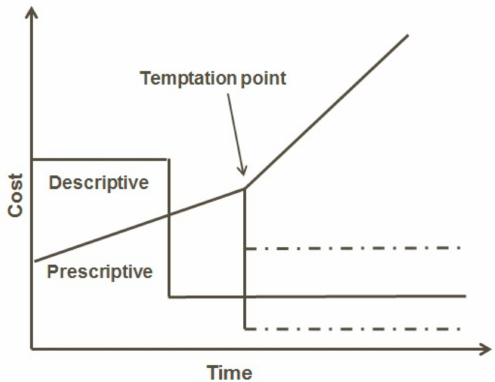
Figure 4. Linearized cost vs. time plots for prescriptive and descriptive